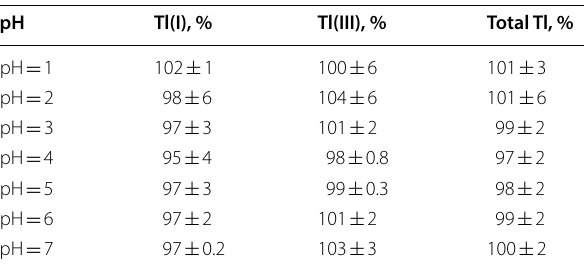
The samples at pH from 1 to 7 contain 3500 ng Tl(I) and 3800 ng Tl(III) in 3–8 mL. The results are presented as mean